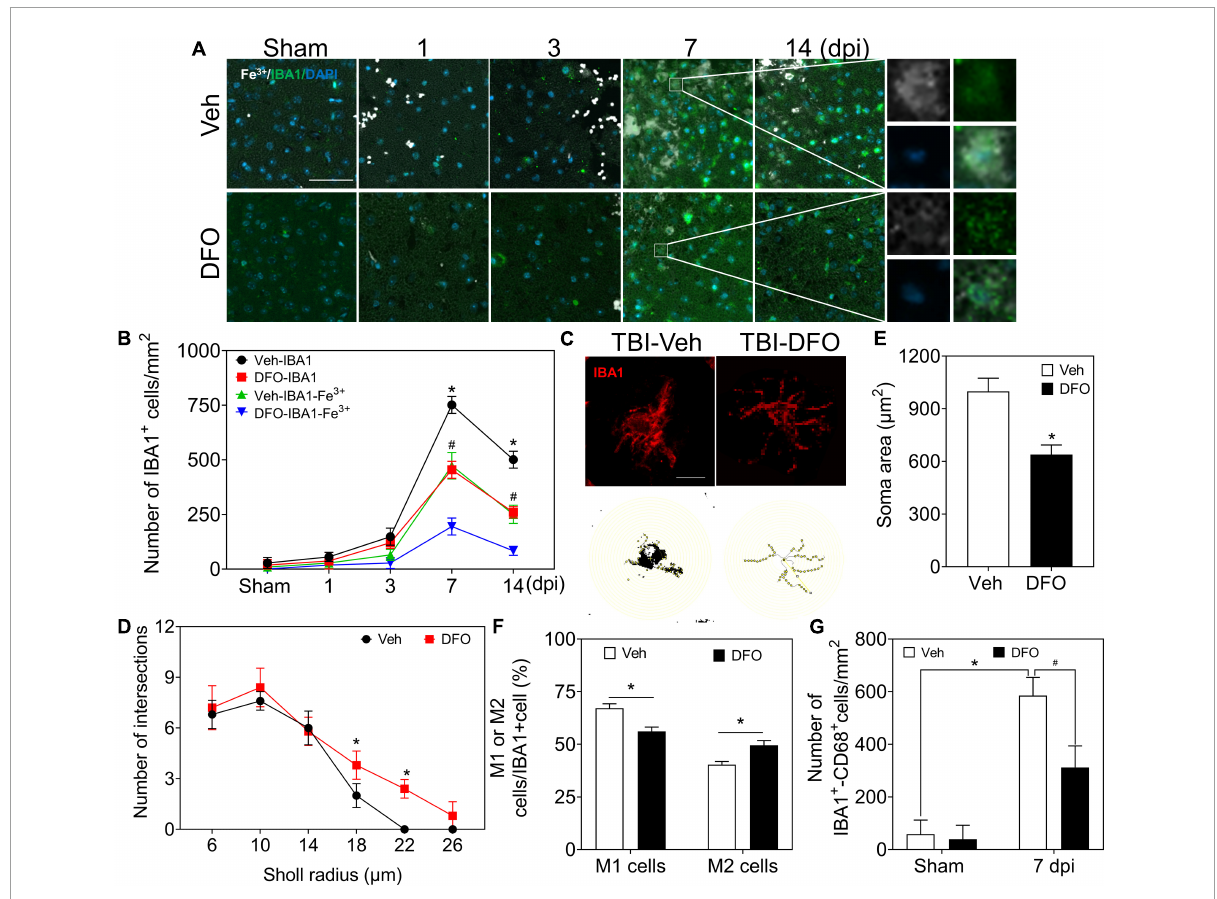
FIGURE5 Microglia play a prominent role in iron metabolism, and iron is associated with microgliosis. (A) Representative colocation image of Fe 3 + and IBA1 in ipsilateral-injured cortices of mice treated with Veh or DFO at the indicated time ( n = 3, scale bar = 50 µ m). (B) Quantitative analysis of the number of Fe 3 + -IBA1- or IBA1-positive cells in panel (A) . Data are presented as mean ± SD. * p < 0.05 versus the Sham group, # p < 0.05 versus the DFO group. (C) Sholl analysis of the morphology of microglia in injured cortices of mice after 7 days treatment of Veh or DFO ( n = 6, scale bar = 20 µ m). Number of intersections of microglia (D) and the soma area of microglia (E) in each group. Data are presented as mean ± SD, and n = 6. * p < 0.05 versus the Sham group. (F) The ratio of M1 cells or M2 cells in injured cortices of mice after 7 days treatment of Veh or DFO. Data are presented as mean ± SD, and n = 6, * p < 0.05 versus the Sham group. (G) Quantitative analysis of CD68-IBA1-positive cells in injured cortices of mice after 7 days treatment of Veh or DFO, Data are presented as mean ± SD, and n = 6. * p < 0.05 versus the Sham group, # p < 0.05 versus the Veh group. IBA1, ionized calcium binding adaptor molecule 1; DFO, deferoxamine; Veh, traumatic brain injury + vehicle; SD, standard